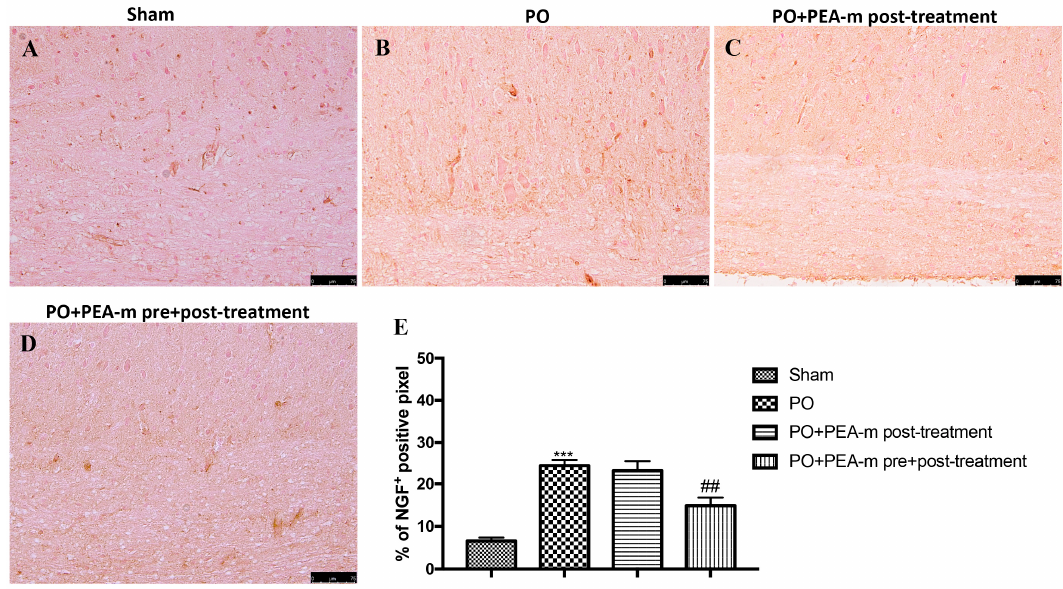
Figure 3. Effects of PEA-m on levels of nerve growth factor (NGF). Immunohistochemical analysis showed no staining for NGF in the sham group ( A ). Increased NGF expression was observed in lumbar spinal cord collected 24 h after PO ( B ). A non-significant reduction was observed in PO + PEA-m post-treatment group ( C ), while low levels of this protein were found in rats treated with PEA-m both before and after plantar incision ( D ). The data are expressed as percentage of pixel cells ( E ). *** p < 0.001 vs. sham; ## p < 0.01 vs. PO.